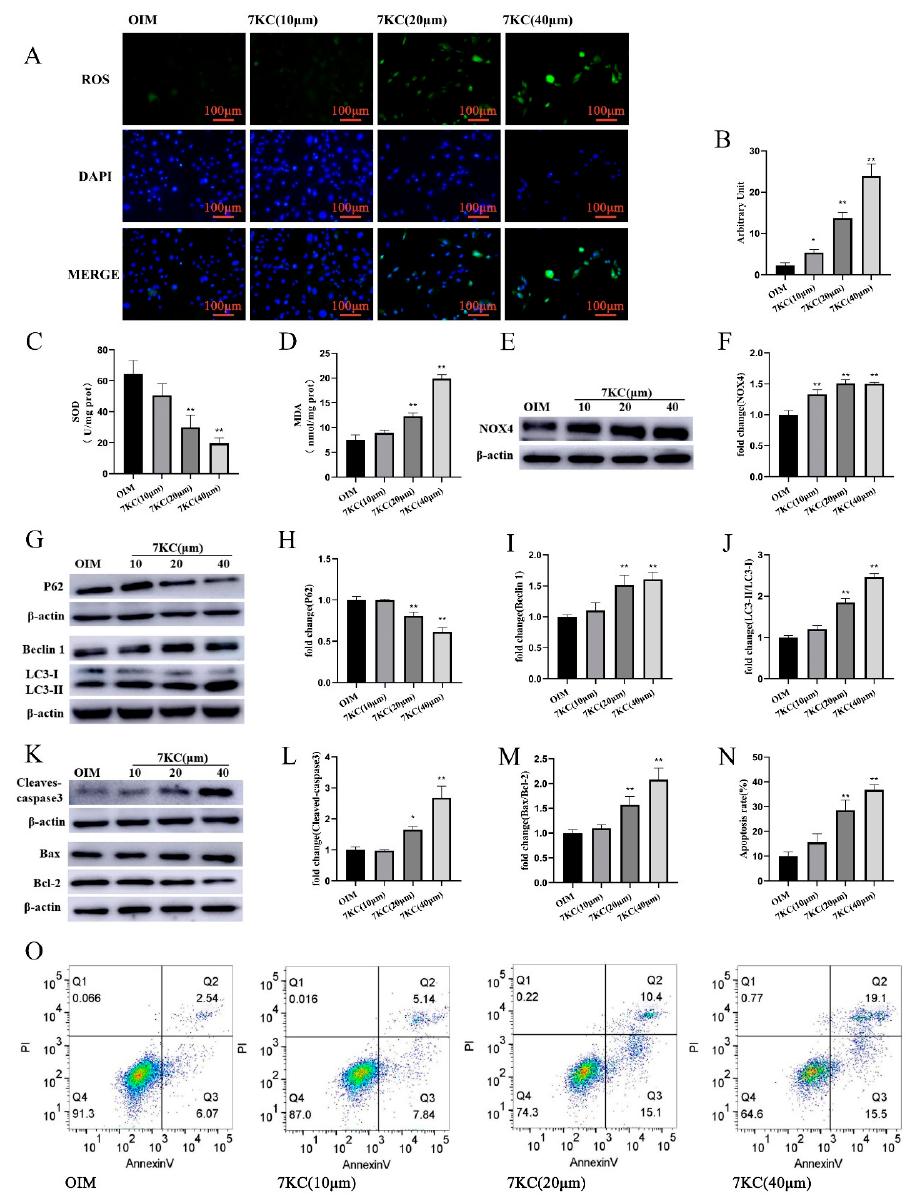
Figure 3. 7KC regulated oxiapoptophagy in MC3T3-E1 cells. ( A ) Cells were prepared for staining with DCFH-DA and DAPI, respectively, and analyzed by a fluorescence microscope (×200 magnification). ( B ) Quantitative analysis of ROS production. ( C , D ) SOD activity detection, and MDA level measurement were conducted using the kits. ( E , F ) The protein expression of NOX4 was analyzed by Western blot. ( G – J ) The protein expression of LC3I/II, Beclin1, and P62 was detected. ( K – M ) The protein expression of Bax/Bcl-2 and cleaved caspase-3 was measured. ( N , O ) Apoptosis analysis was conducted by flow cytometry. Data were analyzed and compared with the OIM group. * p < 0.05; ** p < 0.01. OIM, osteogenic induction medium; NC, negative control.